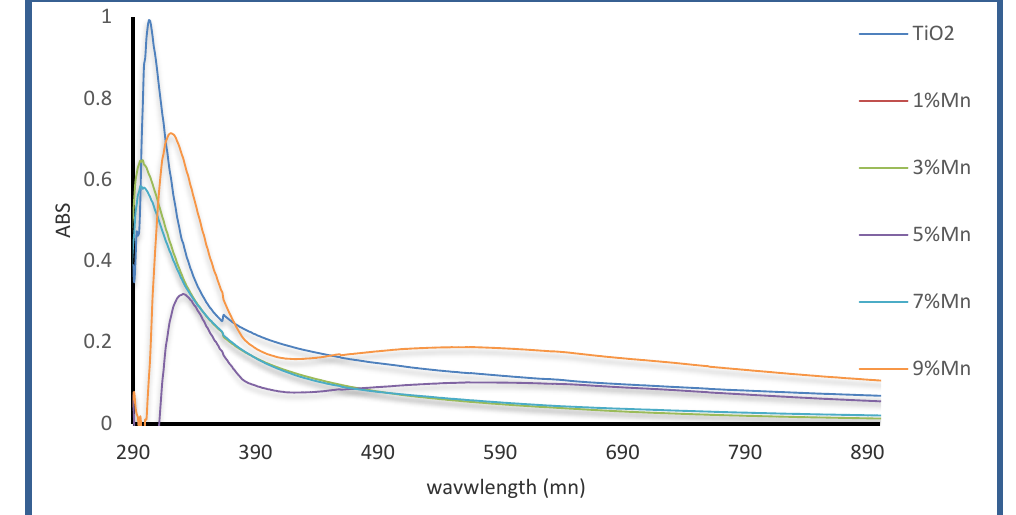
Fig.5: The pure and Mn-doped TiO